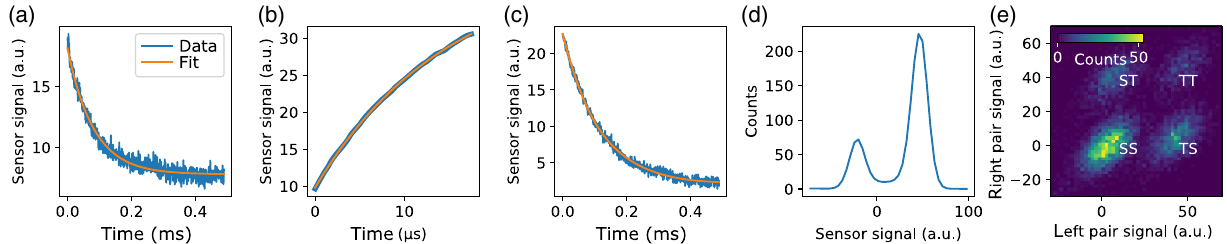
FIG. 10. Readout characteristics (a) – (c) show relaxation curves for the Pauli spin blockade readout of the left, middle, and right pair, respectively. The corresponding T 1 values are 80.9, 25.0, and 114 . 8 μ s. (d) Histogram of middle-pair readout with 8 μ s integration time and bin width 4.375 a.u., and the counts are in thousands. (e) Histogram of correlated left- and right-pair readout. For both readouts, the integration time is 8 μ s, and the bin width is [2.0, 2.0]